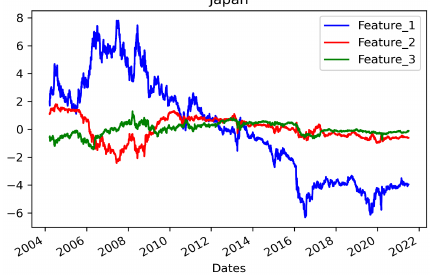
Figure 9. Features of Japan term structure.